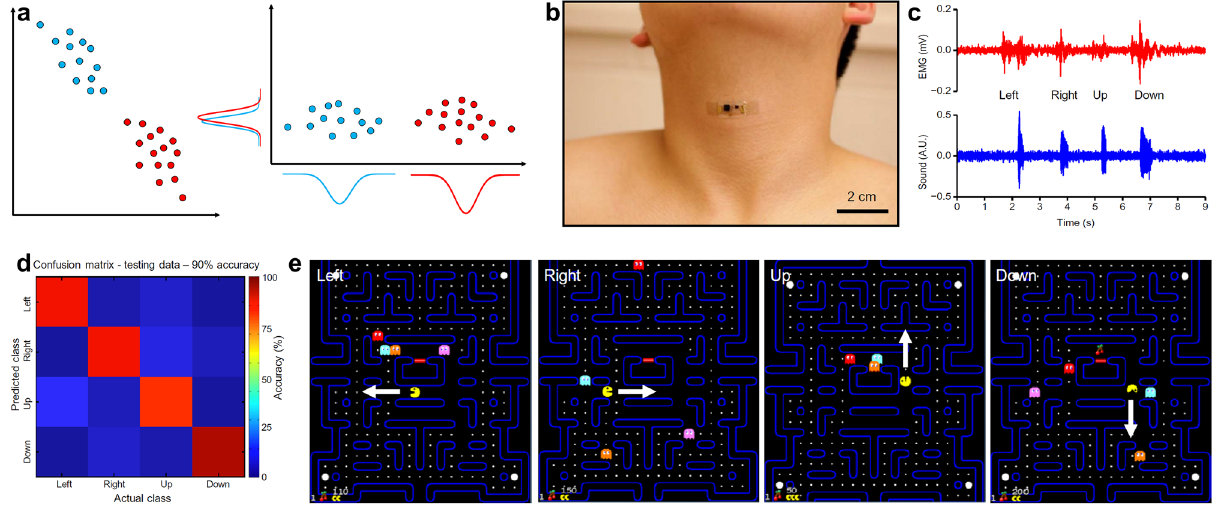
Fig. 16 Signals detected by the soft system and processed by LDA. a Schematic diagram of LDA. b Photograph of an epidermal mechanoa- coustic sensing electronics attached on the vocal cords. c EMG (top) signals and vocal vibrational (bottom) signals detected simultaneously from the neck. d Confusion matrix of the result of the speech classification. e Demonstration of speech recognition and classification in a Pac-Man game, which can realize left, right, up, and down instruction. Reproduced with permission [27]. Copyright (2016), American Association for the Advancement of